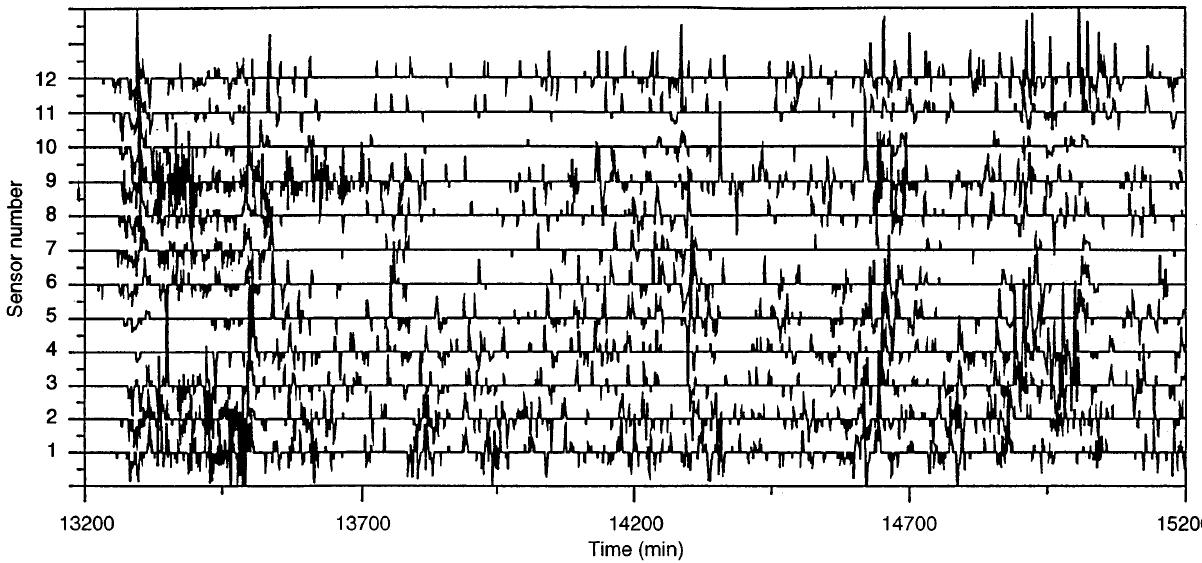
( the upper record ) are sequentially displaced by 0.5 (cid:176) C/min (i.e. the sensor separation corresponds to changes in temperature of 0.425 (cid:176) C per min)